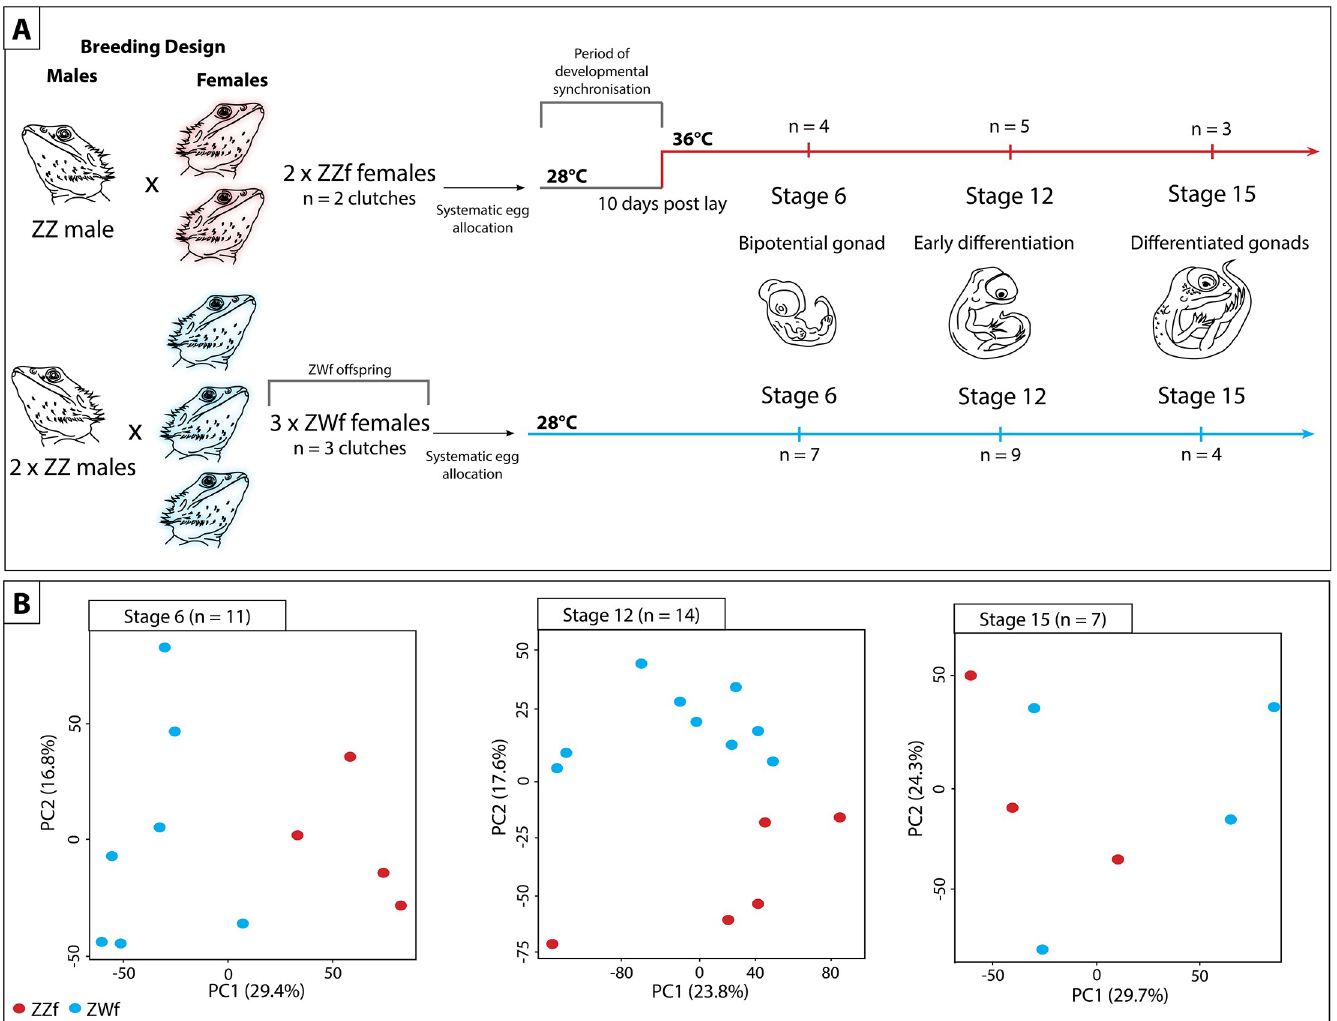
Fig 1. Schematic representation of experimental design used in this study to compare the differences between genetic sex determination and temperature dependent sex determination. ( A ) Summary of experiment showing how the parental crosses were designed, and how eggs were allocated and incubated. Eggs from sex reversed females (ZZf) were initially incubated at 28˚C for 10 days, then were switched to 36˚C. Eggs were sampled at the same three developmental stages (6, 12, and 15) based on [19,20].At stage 6 the gonad is bipotential, at stage 12 the gonad is in the early stages of differentiation, and it completely differentiated by stage 15. Eggs from concordant females (ZWf) were incubated at 28˚C and sampled at the same three developmental stages as the ZZf eggs. ( B ) PCA plots showing the first and second principal components of read count per gene between ZZf (red) and ZWf (blue) at each stage of